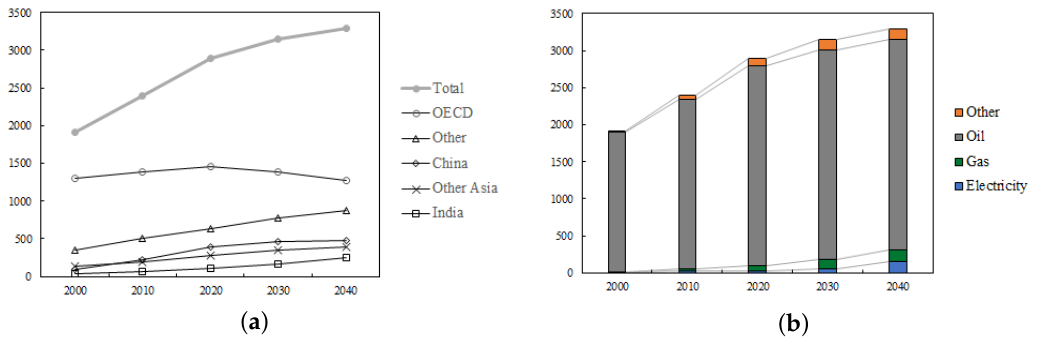
Figure 3. ( a ) Energy consumption (in billion toe) in transportation by region. ( b ) Energy consumption in transportation by fuel